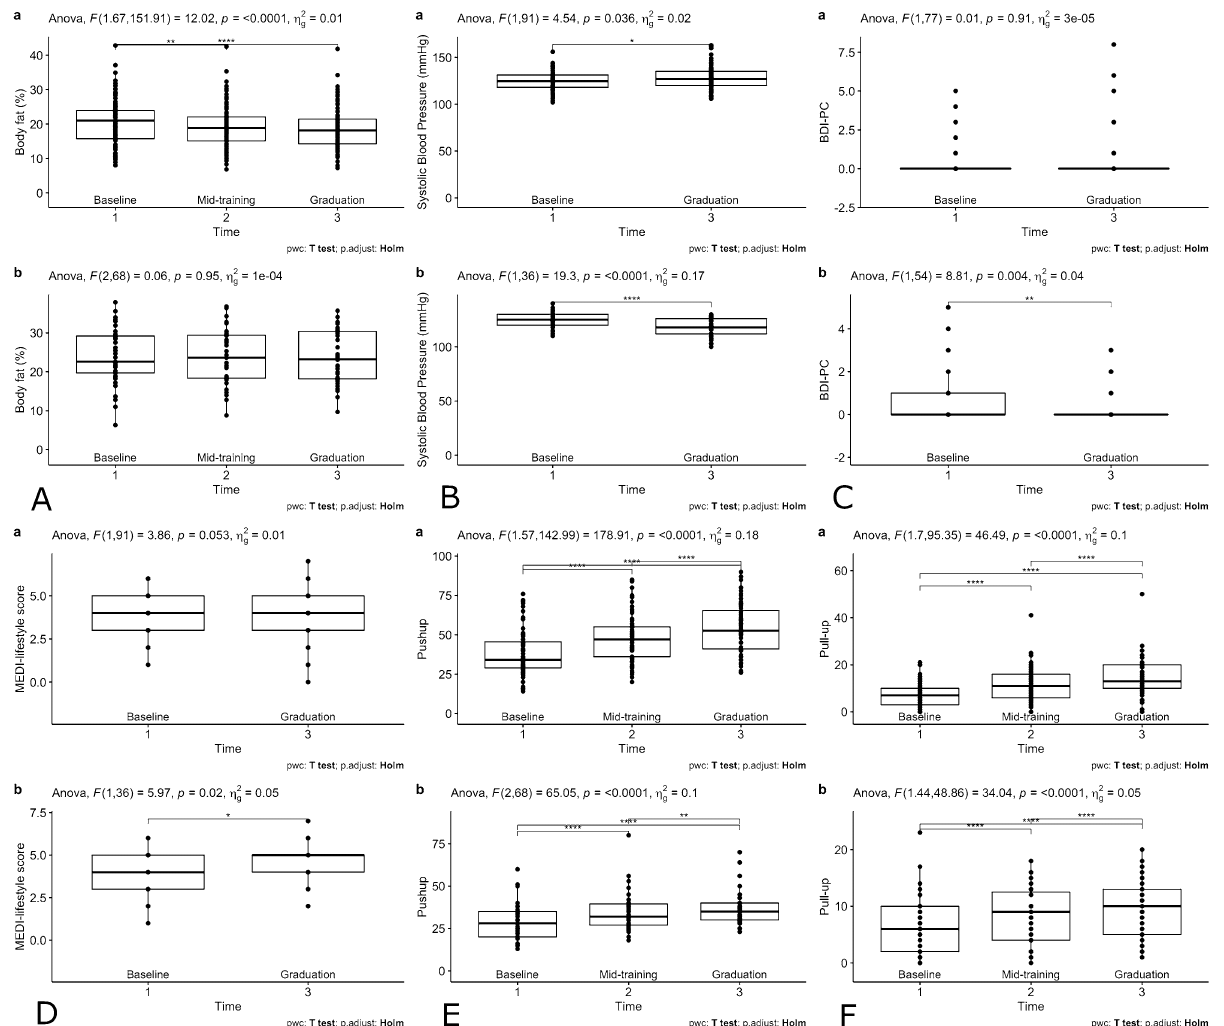
Figure 1. Box plots showing the distributions of recruits’ selected health profiles at baseline, mid-training, and academy graduation comparing ( a ) the historical control group (n = 92) and ( b ) the intervention group (n = 55). A. Body fat; B. systolic blood pressure; C. BDI-PC (Beck Depression Inventory for Primary Care); D. MEDI- lifestyle score; E. push-ups; F. pull-ups. The plots were derived from the recruits whose data were available at each time point. Post-hoc paired analysis with Holm adjustments were demonstrated by * P < 0.05, ** P < 0.01, *** P < 0.001, **** P < 0.0001. Body fat, systolic blood pressure, push-ups, pull-ups, and MEDI-lifestyle score are only available for one academy of the intervention group (n =